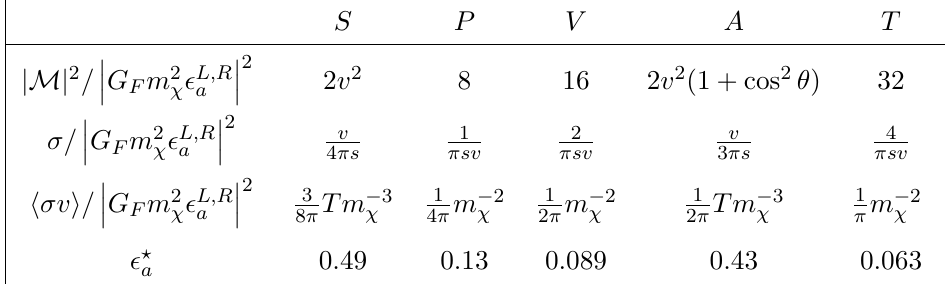
Table 1 . Annihilation amplitudes ( |M| 2 ), cross sections ( σ ), thermally averaged cross sections ( h σv i ), and benchmark values of (cid:15) ? used in eq. (2.16) for the five types of effective interactions. a We neglected the mass of the final states and assume that the annihilating DM particles are non- relativistic with v being their relative velocity. The results have been expanded in v and only leading-order terms are retained. Results for (cid:15) R and (cid:15) L are identical. a a where (cid:15) ? denotes benchmark values: (cid:15) ? = 0 . 49 , (cid:15) ? = 0 . 13 , (cid:15) ? = 0 . 089 , (cid:15) ? = 0 . 43 , and a S P V A (cid:15) ? = 0 . 063 . Note that (cid:15) ? for a = S or A is generally larger than for other cases because a T the cross section is velocity suppressed, which implies that they would freeze out at higher temperatures for the same coupling strength. Hence to reach the same relic